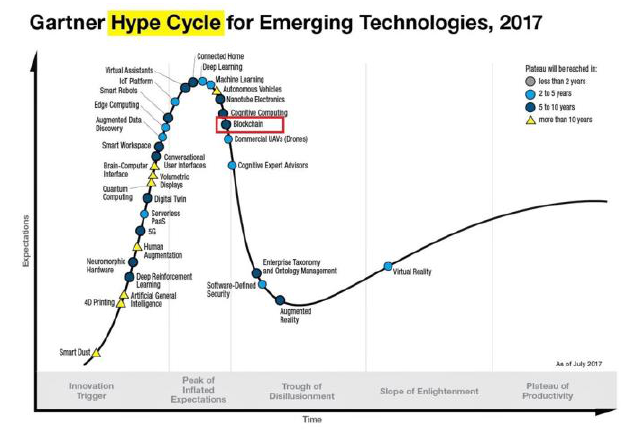
Figure 3. Blockchain on Gartner Hype